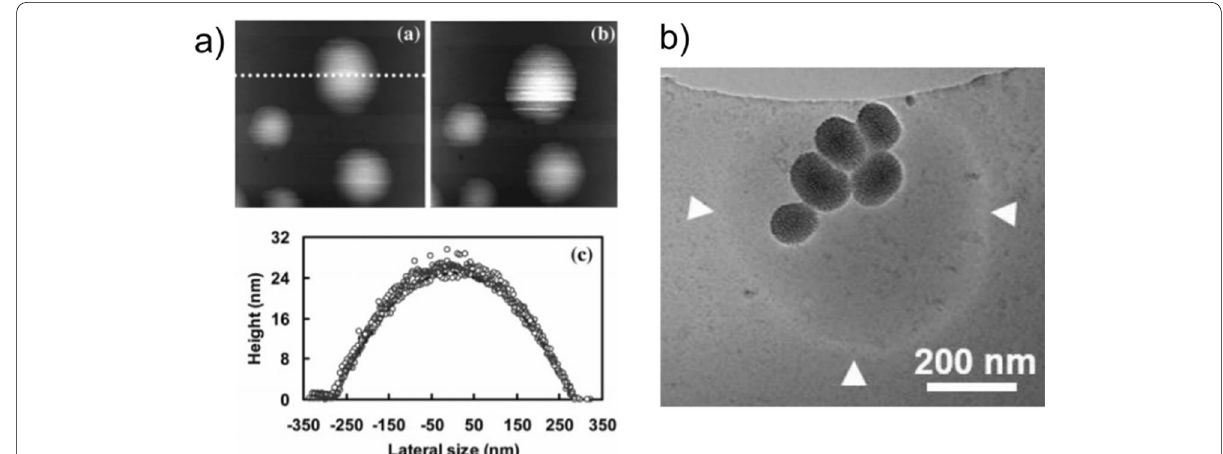
Fig. 2 a AFM images of nanobubbles formed on an octadecyltrichlorosilane modified silicon substrate. Adapted from reference [65], Copyright 2006, American Chemical Society, b Cryo-EM image of a bubble stabilized by hydrophobic MSNs. Adapted from reference [73], Copyright 2021, John Wiley and